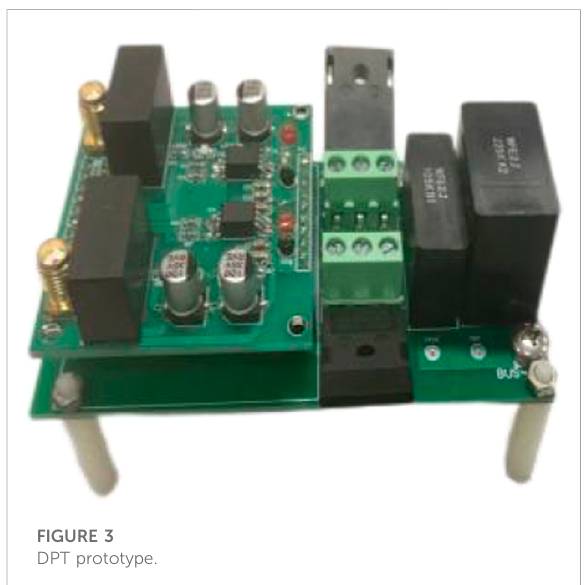
Frontiers in Energy